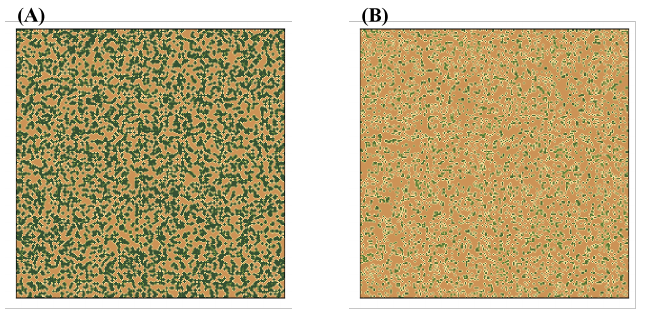
Figure 6. Simulated vegetation patterns in different years. ( A ) The Jornada Basin’s 2005 simulated vegetation pattern. R = 0.71, T = 21, V 2 = 0.02, V 4 = 0.03, and C a = 400. ( B ) The 2019 simulated vegetation pattern. R = 0.55, T = 32, V 2 = 0.02, V 4 = 0.03, and C a = 400. Yellow area: bare soil. Green area: